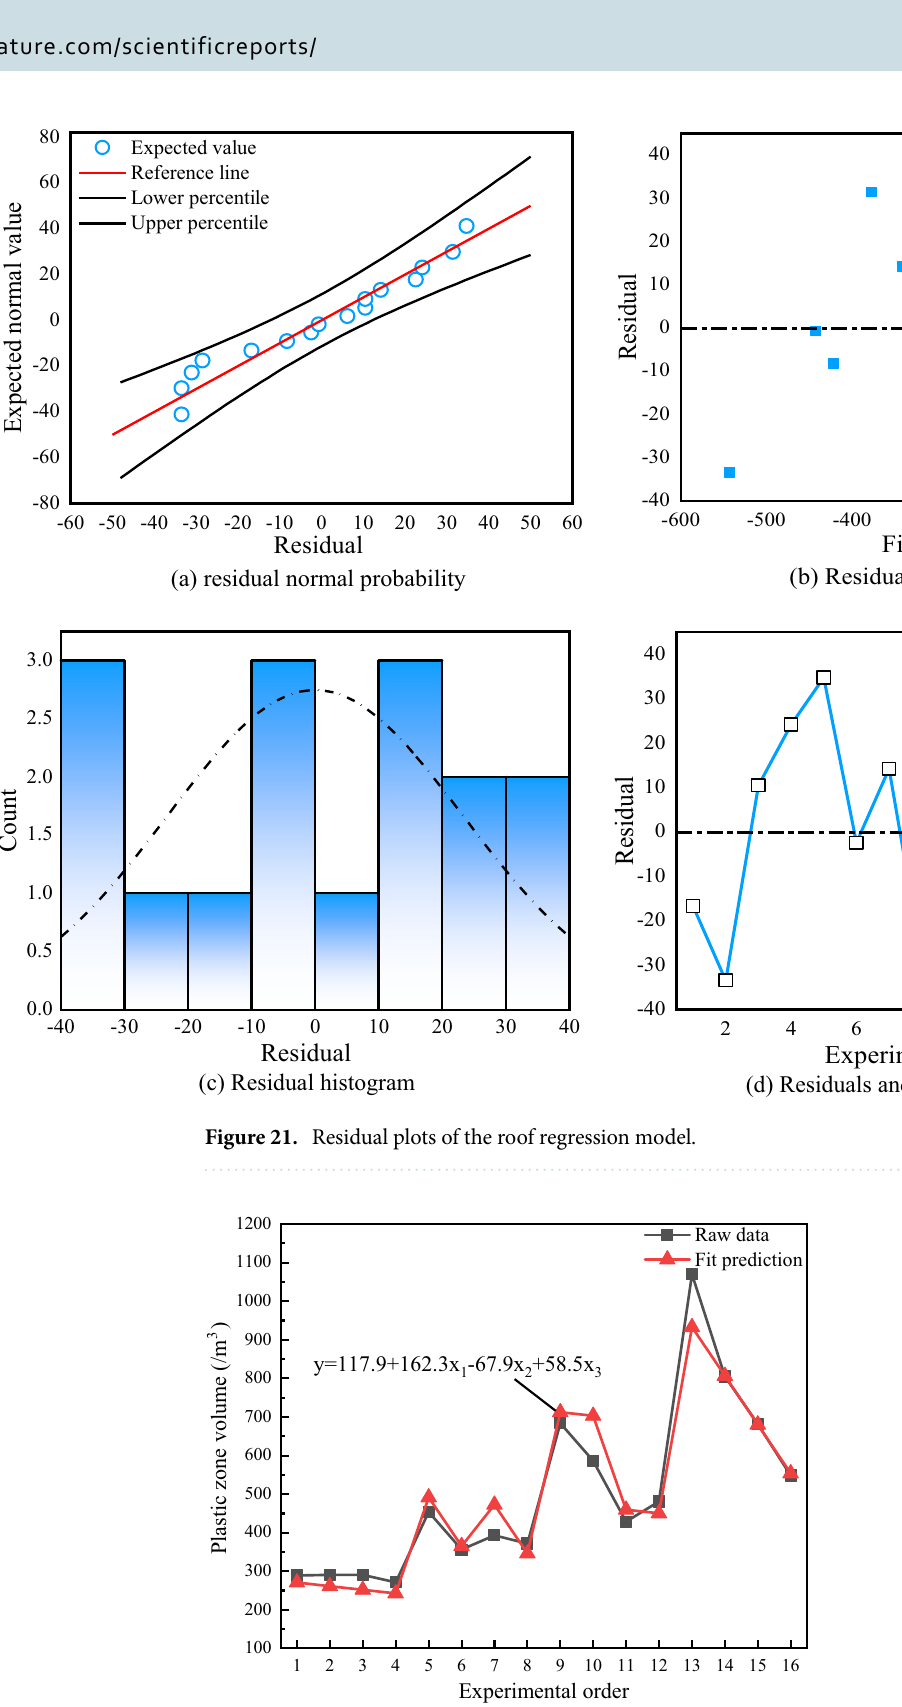
Figure 22. Comparison between the plastic zone volume regression model and the original experimental